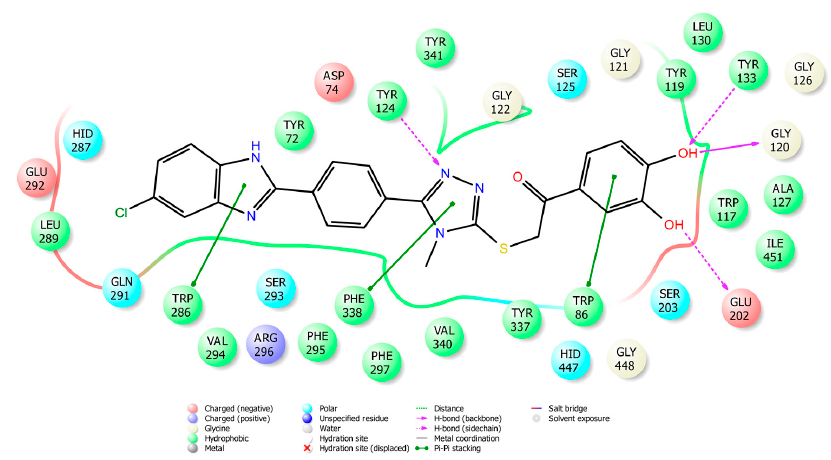
Figure 4. Two-dimensional interaction mode of compound 3d in the enzyme active site of AChE.